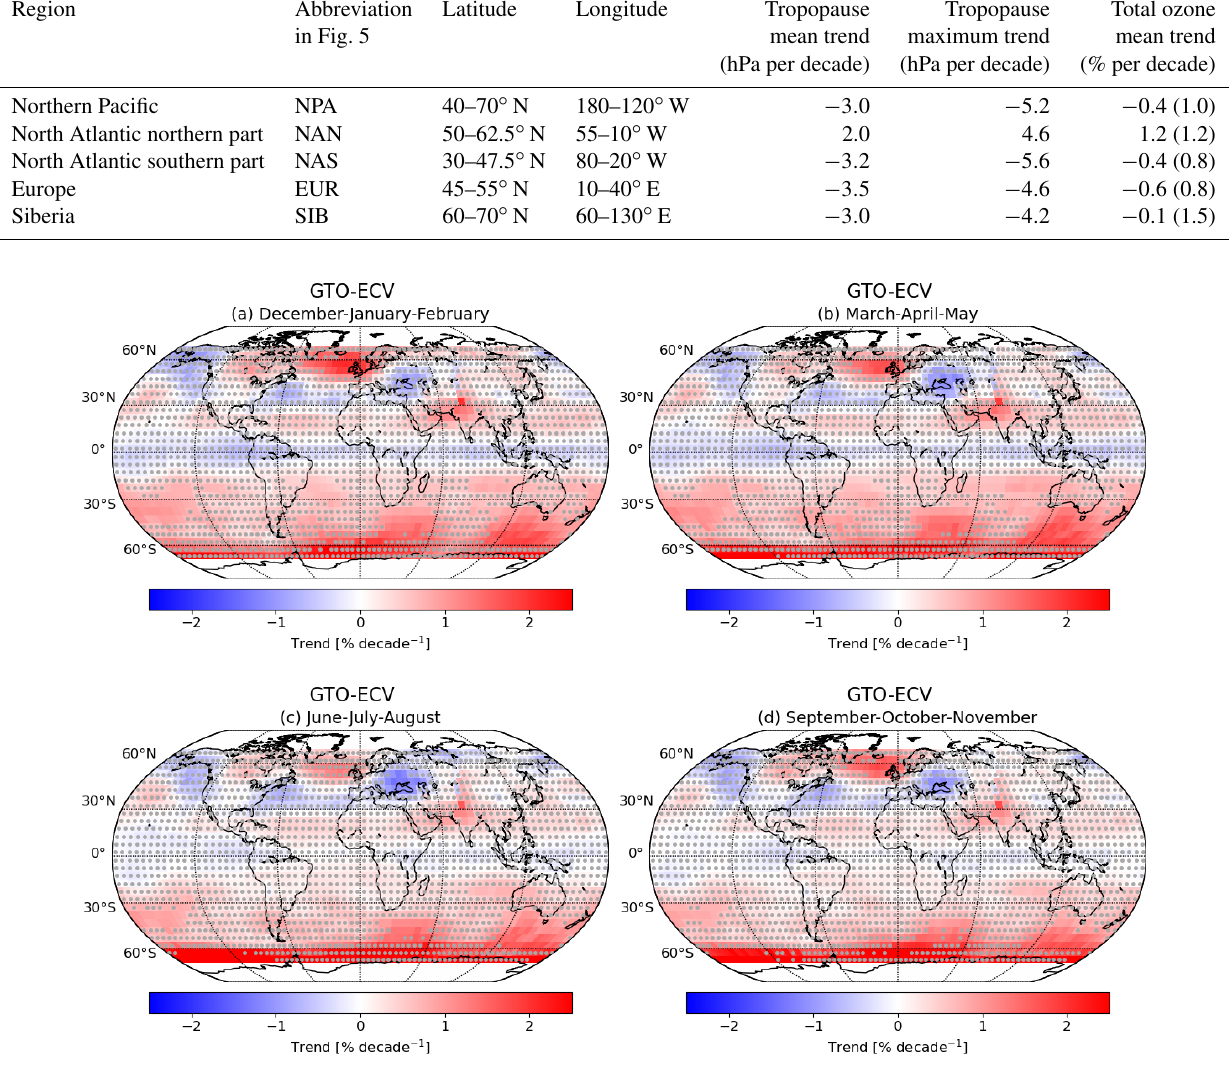
Figure 6. Total ozone trend for 1997–2020 (in % per decade) derived from the GTO-ECV data record as a function of season: (a) December, January, February (DJF), (b) March, April, May (MAM), (c) June, July, August (JJA), and (d) September, October, November (SON). Grey dots signify that the trend is statistically not